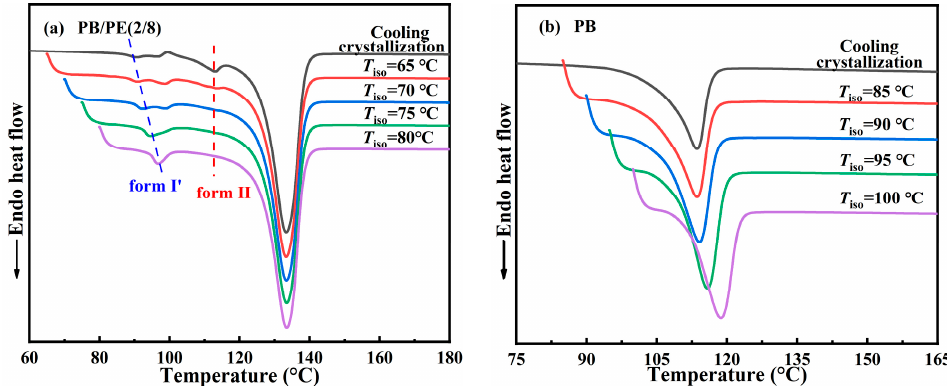
Figure 6. The DSC heating curves of ( a ) PB/PE(2/8) and ( b ) PB after isothermal crystallizations at different temperatures.